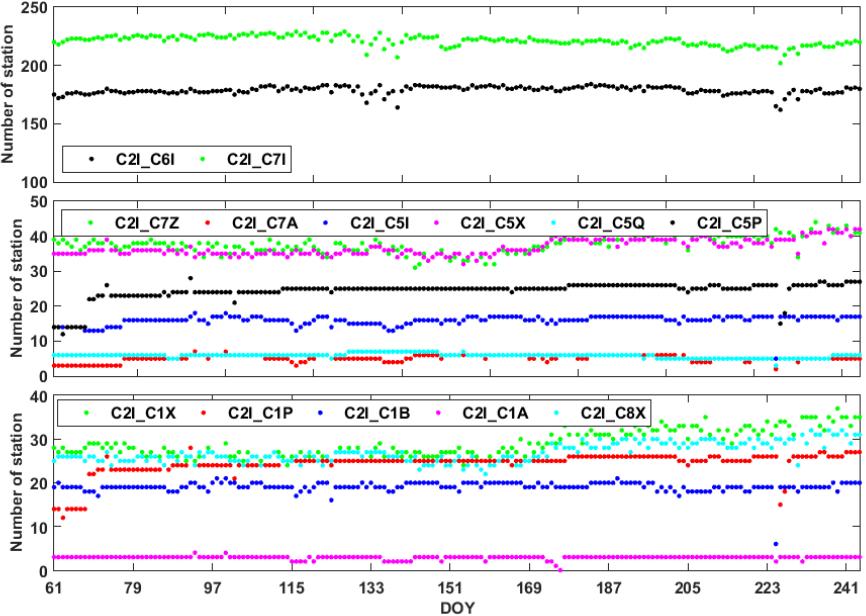
Figure 12. Time series of the daily number of stations used to calculate the DCB solutions.